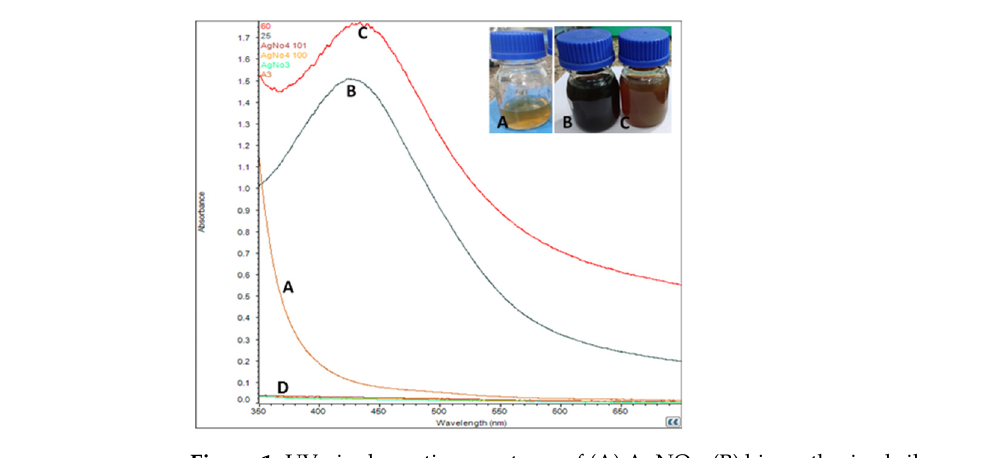
Figure 1. UV-vis absorption spectrum of (A) AgNO 3 , (B) biosynthesized silver nanoparticles at 25 °C and (C) at 60 °C , and Carissa carandas leaf extracts (D, green line).